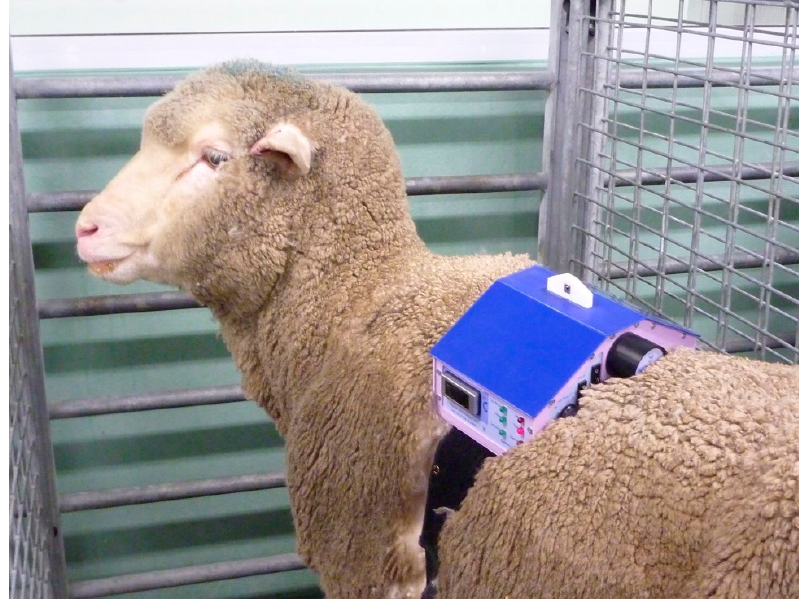
Figure 3. Remote controlled thermal unit on an unrestrained sheep in its pen.